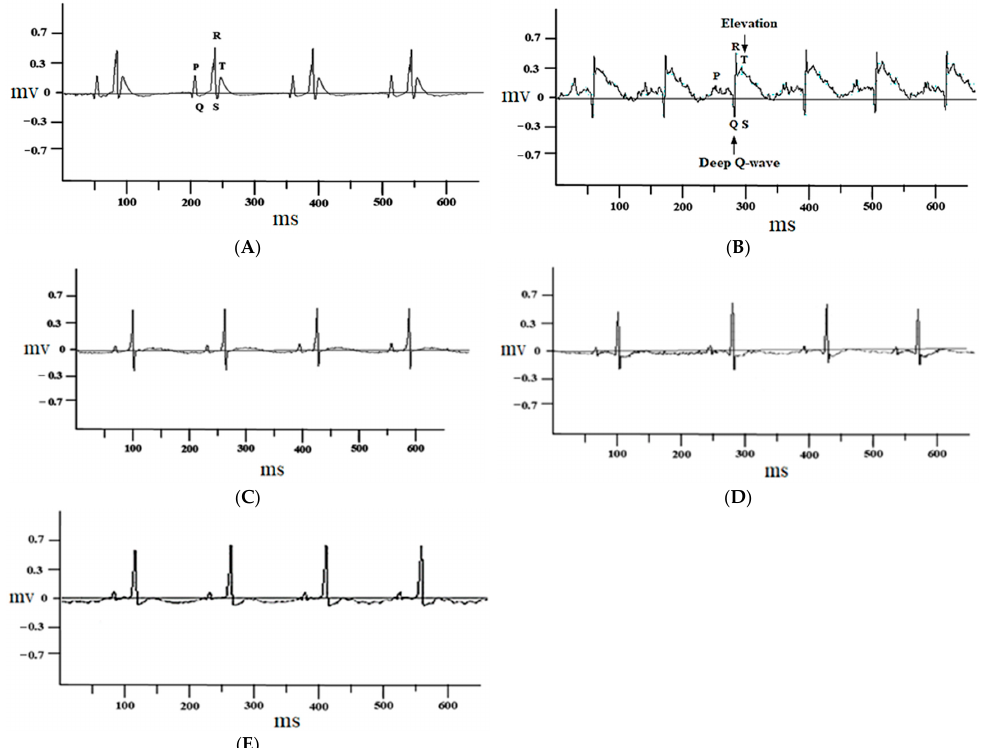
Figure 2. Representative electrocardiogram (ECG) tracing of control ( A ), isoproterenol ( B ), atenolol (1 mg/kg) + ISO ( C ), juglone 1 mg/kg + ISO ( D ) and 3 mg/kg + ISO ( E ) treated rats (recorded from lead II with recording speed 50 ms/div). Millisecond (ms); millivolt (mv).